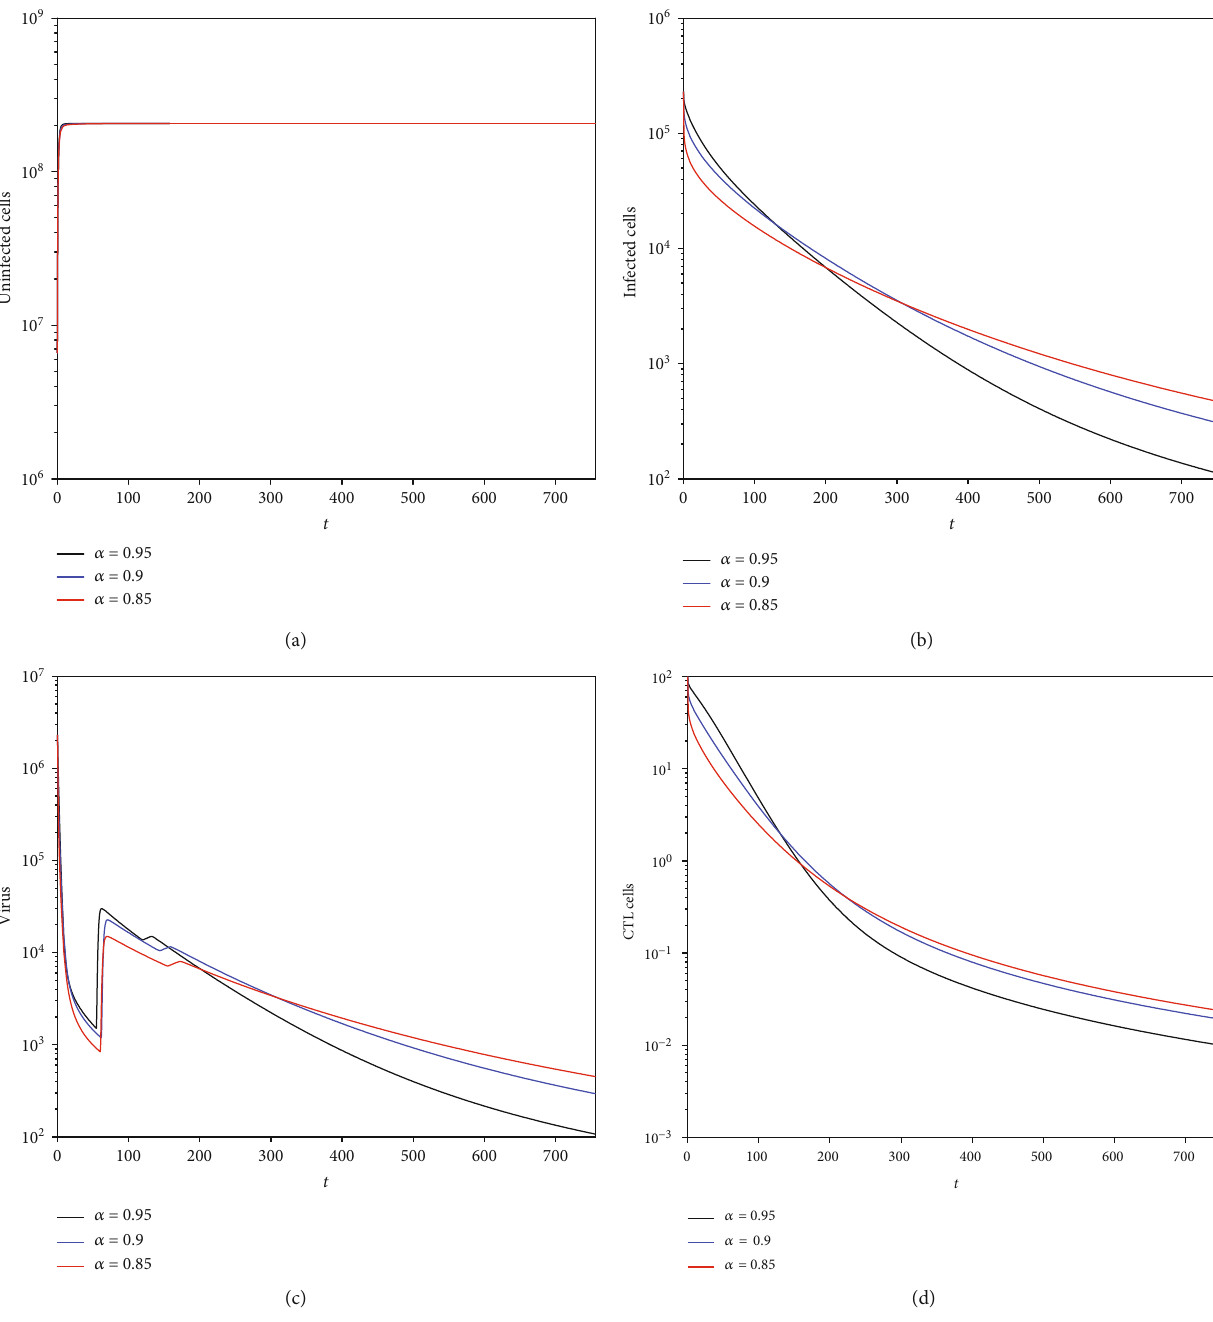
Figure 3: State dynamics of uninfected and infected cells, free virus, and CTL cells with Strategy